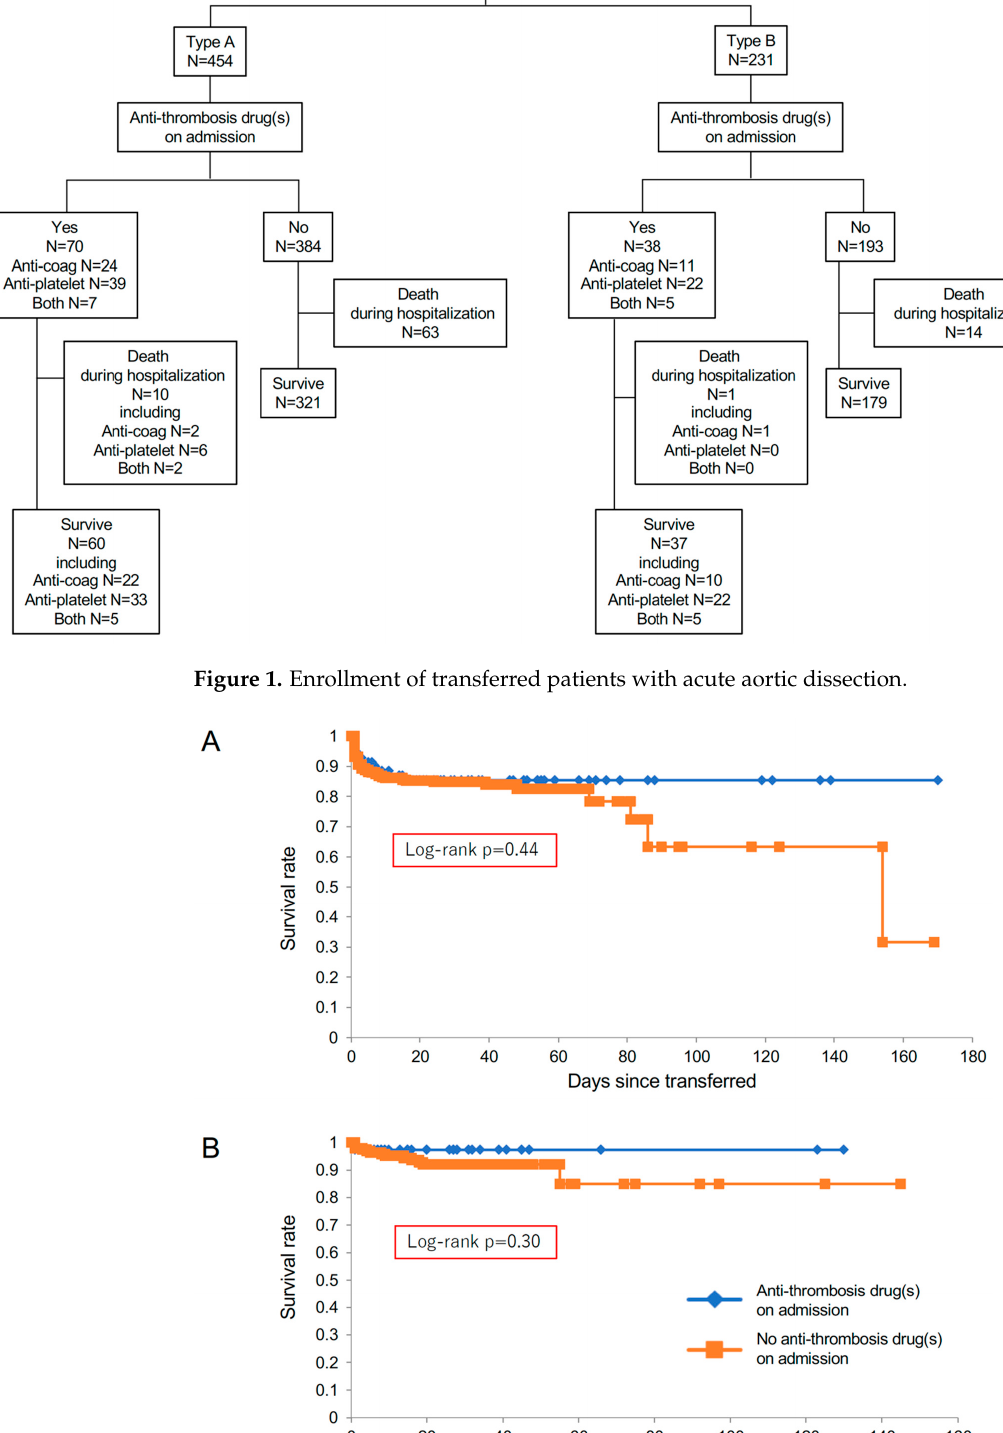
Figure 2. Kaplan–Meier curves of transferred patients with acute aortic dissection. There were no significant differences in survival rates between patients with and without anti-thrombotic drugs on admission, in both type A (panel ( A )) and type B (panel ( B